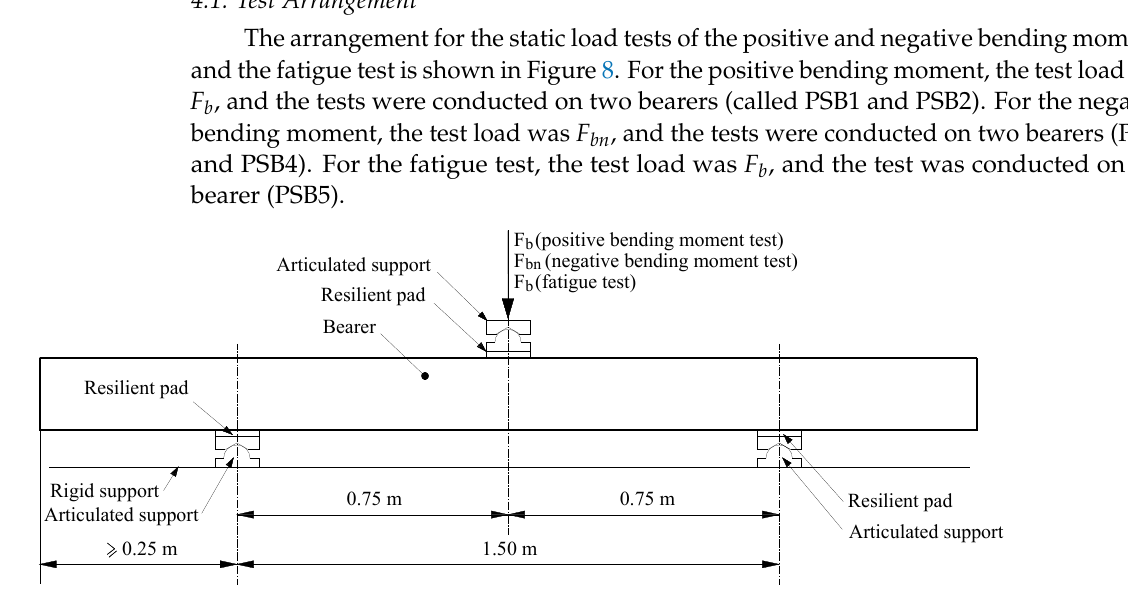
Figure 8. Test arrangement for the positive and negative bending moment tests and fatigue test.